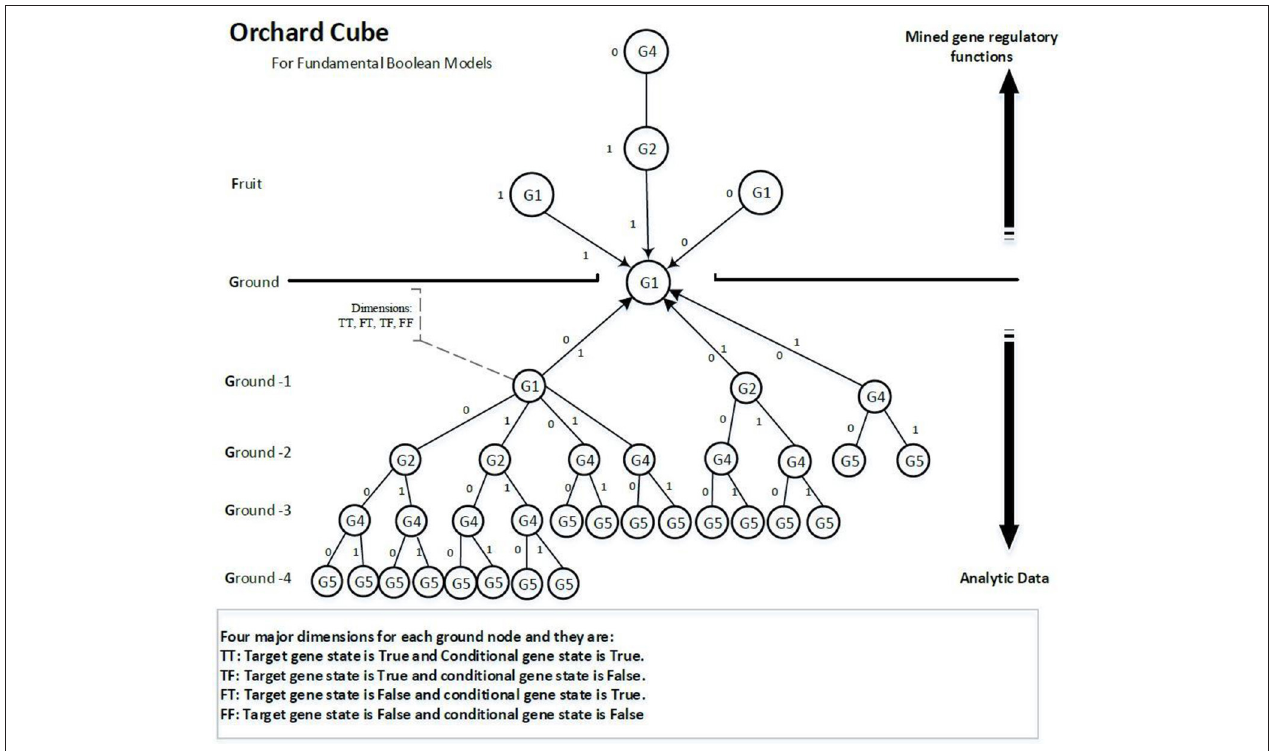
FIGURE 4 | Illustration of an orchard